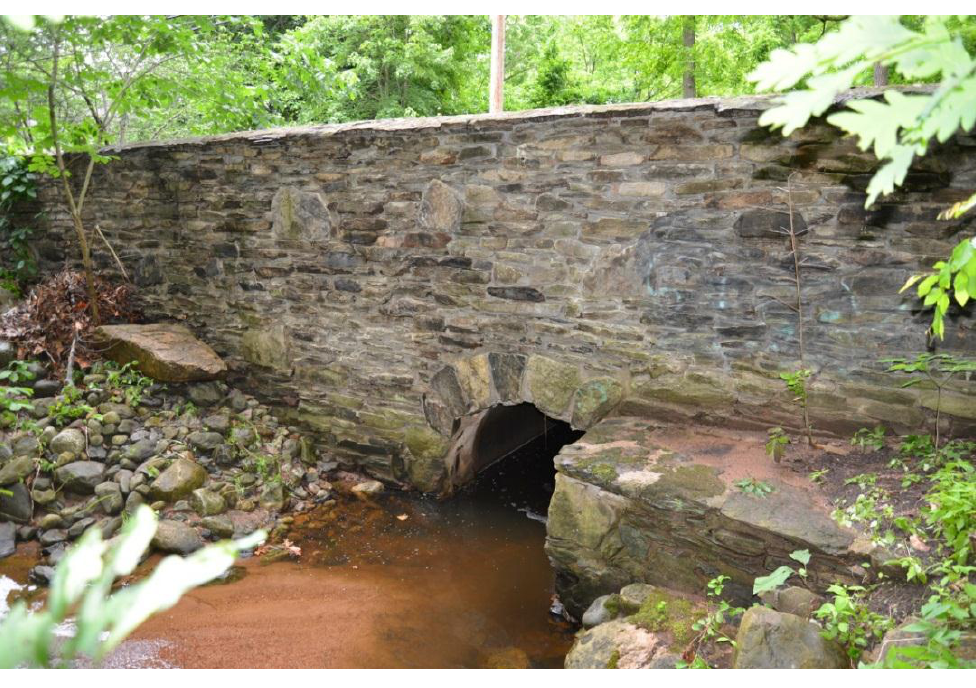
Figure 7. Photograph of inland area #1 (Figures 3 and 4). Photograph taken on 6 June 2015 by Michael Kress and Alan Benimoff College of Staten Island, The City University of New York.